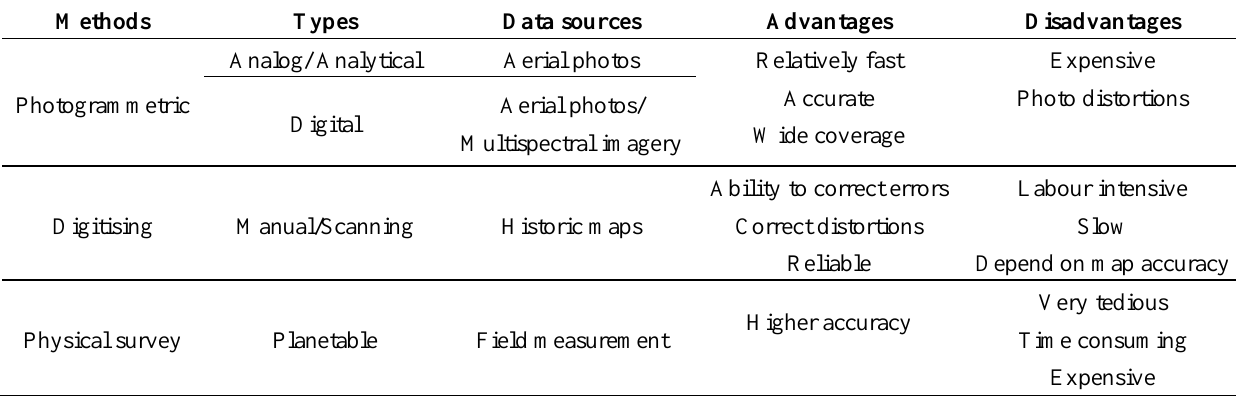
Table 1 . Summary of farmlands mapping